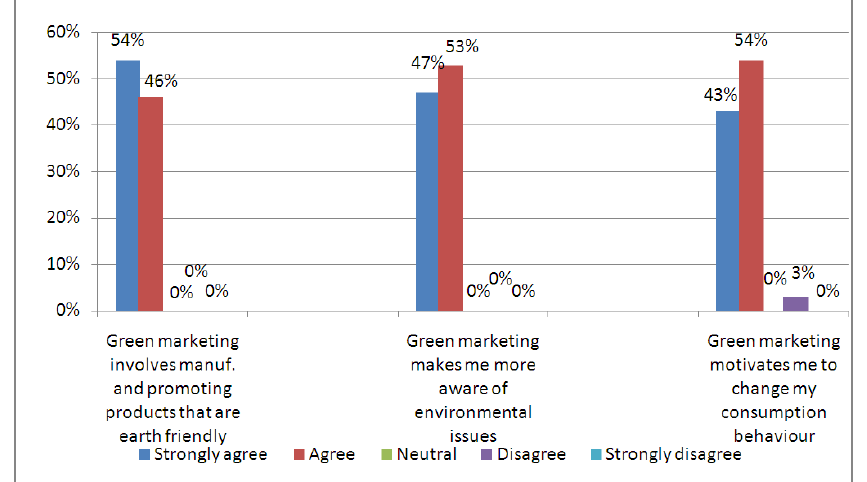
Fig. 3. Knowledge and attitude of respondents towards green marketing